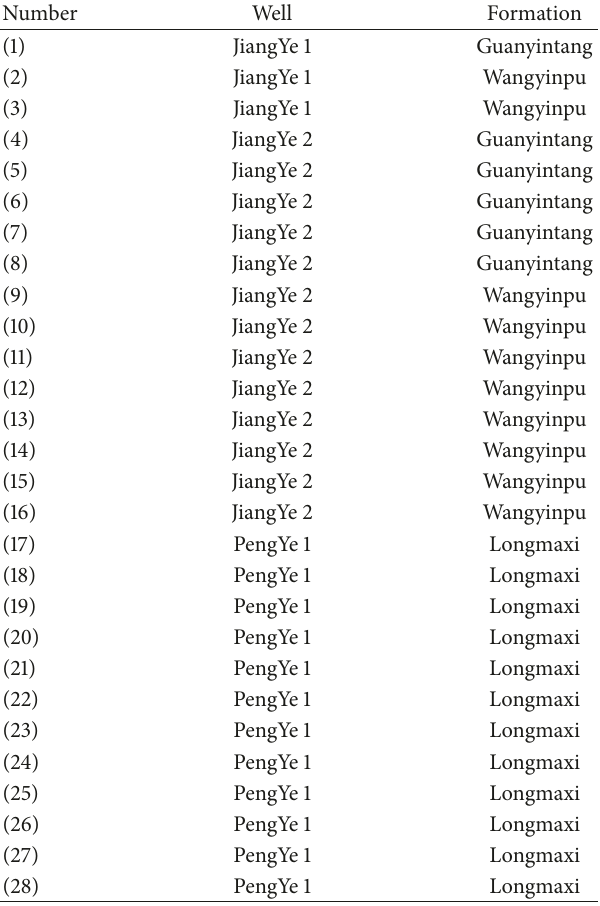
Table 1: Number, well, and formation of the permeability test